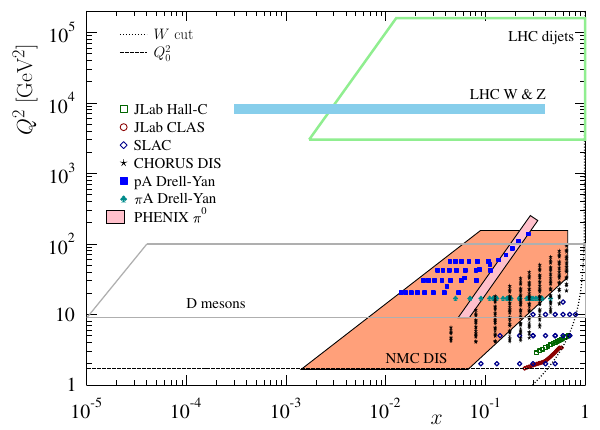
Fig. 2 The data included in the EPPS21 laid schematically on the ( x , Q 2 )